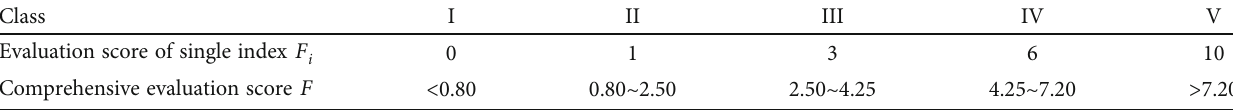
Table 2: Evaluation score of single index and comprehensive evaluation